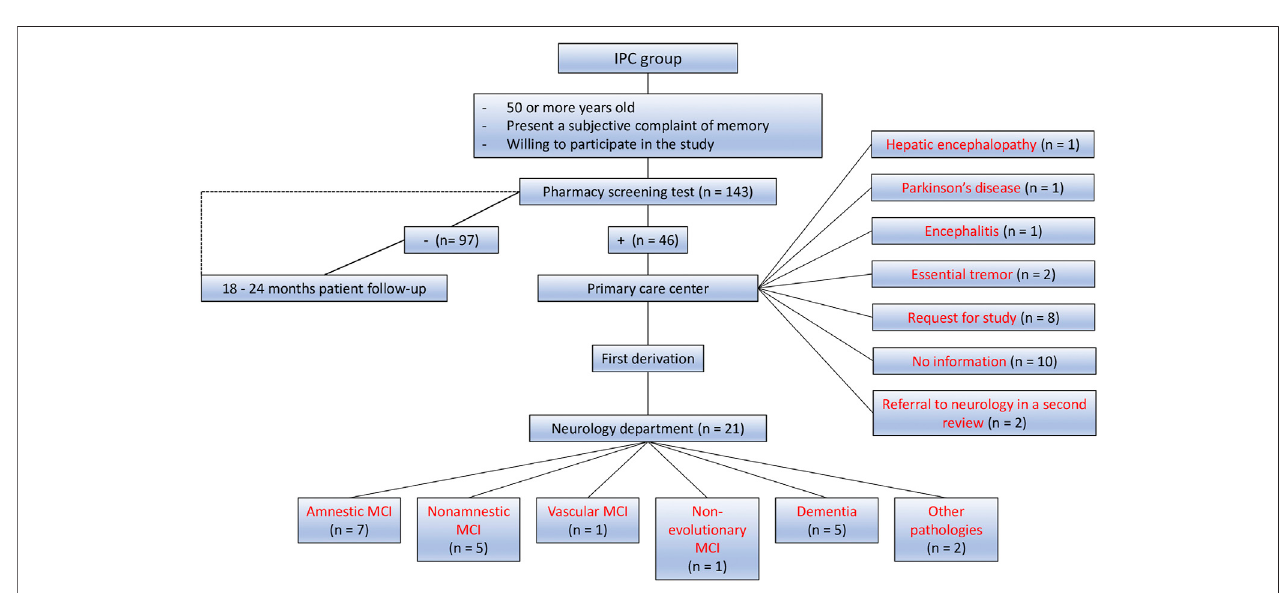
FIGURE 4 | Diagnosis and follow-up of the IPC group at 6 months. The fi gure shows the diagnoses obtained after 6 months of follow-up in the IPC group, both in primary care and in neurology.